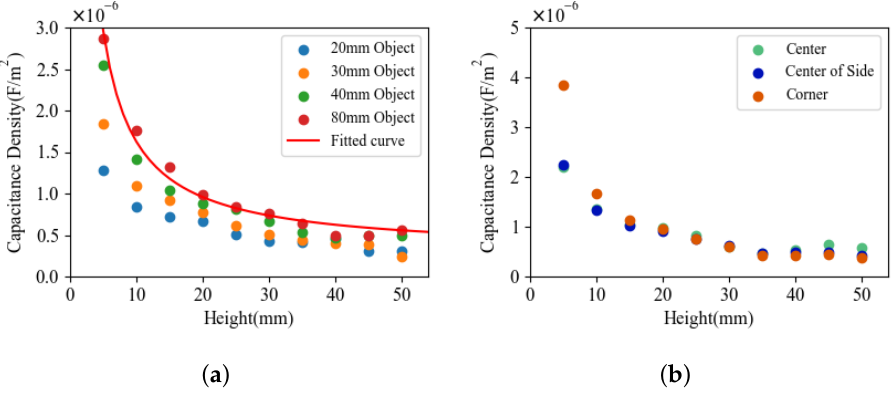
Figure 8. ( a ) Mean capacitance density value at center of position (CoP) reconstructed regarding distance using objects with different size. The red line shows the fitted curve of the 80 mm object. ( b ) Capacitance density value at CoP reconstructed regarding distance with different horizontal position using 80 mm object (Object